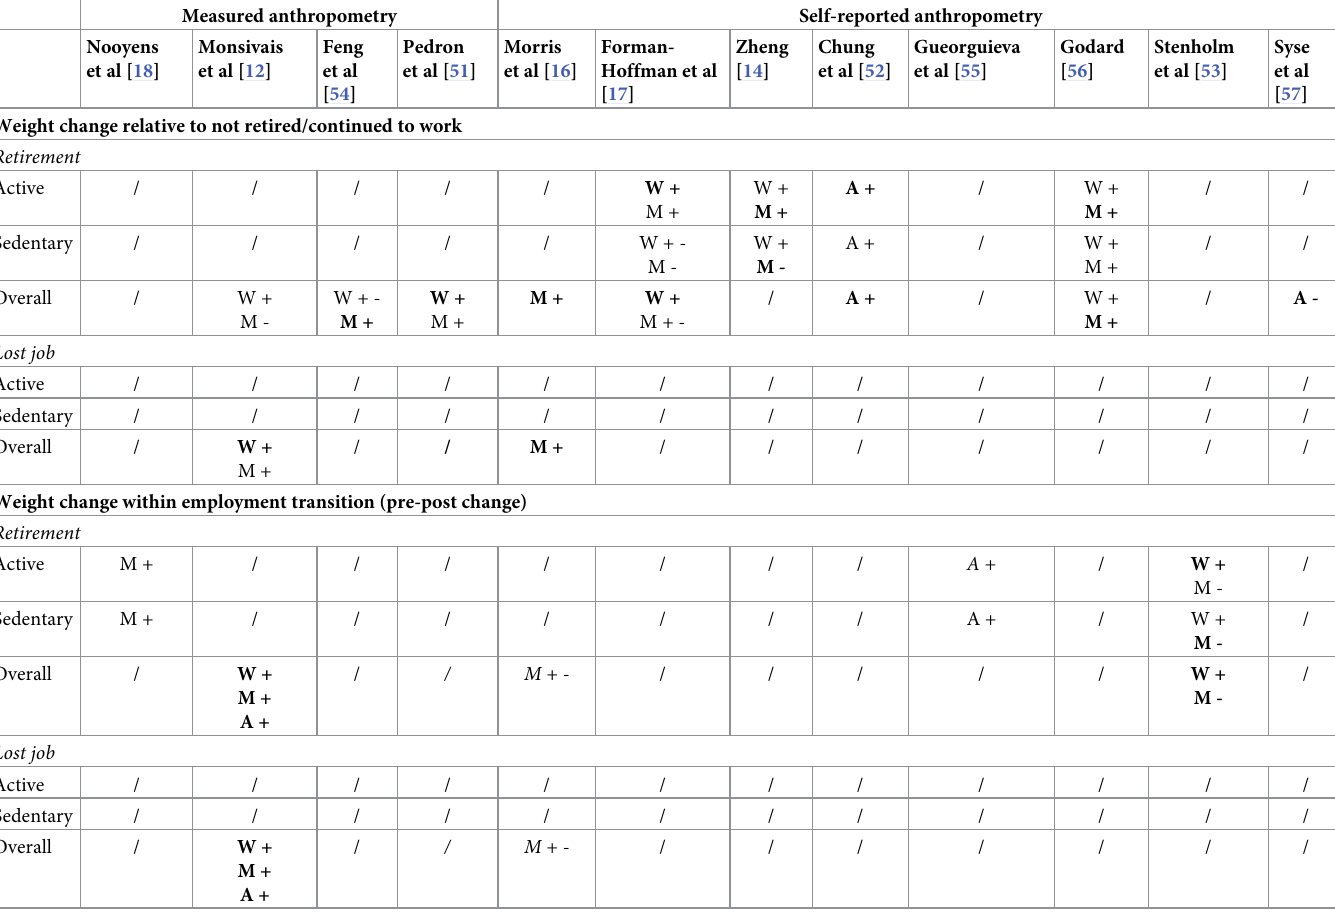
Table 5. Summarised results from included studies by study design, employment transition, and occupation